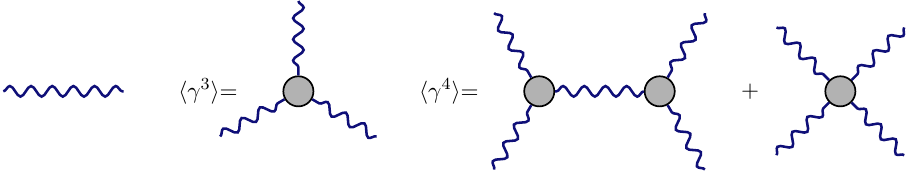
γ 2 , γ 3 , and γ 4 . Wavy h i h i h i